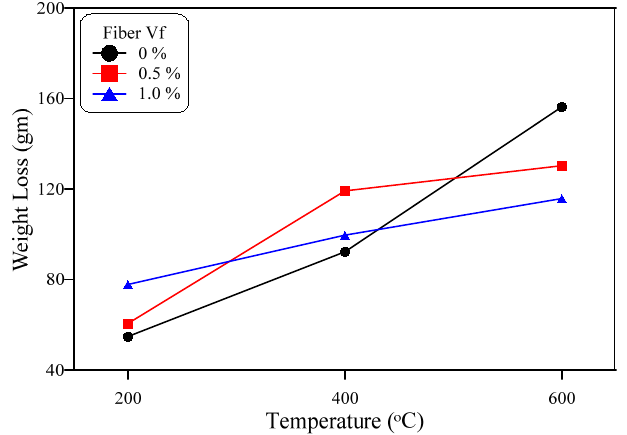
Figure 7. Weight loss of the cube